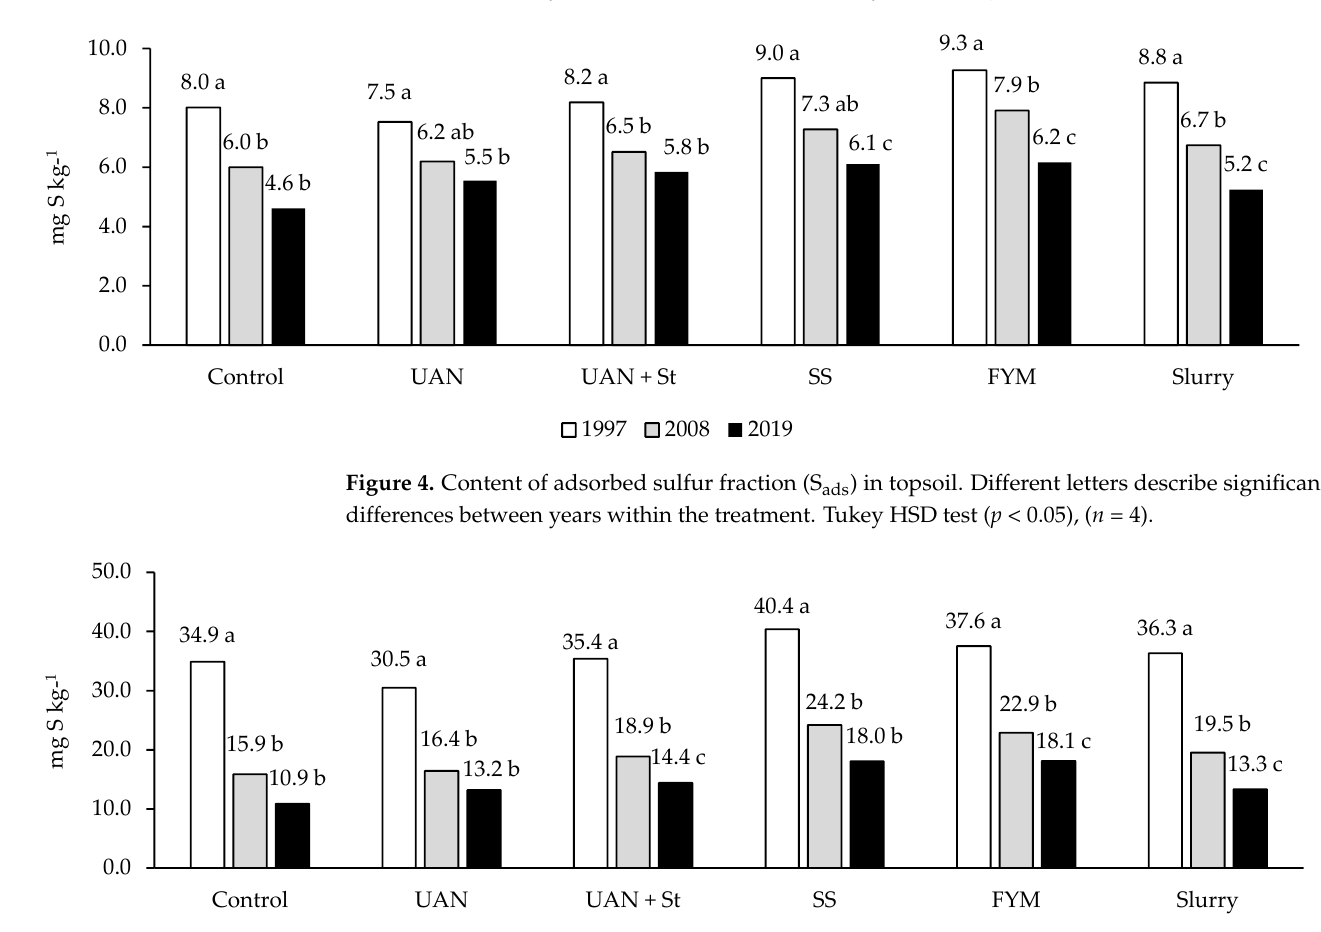
Figure 3. Content of water-soluble sulfur fraction (S W ) in topsoil. Different letters describe significant differences between years within the treatment. Tukey HSD test ( p < 0.05), ( n = 4).